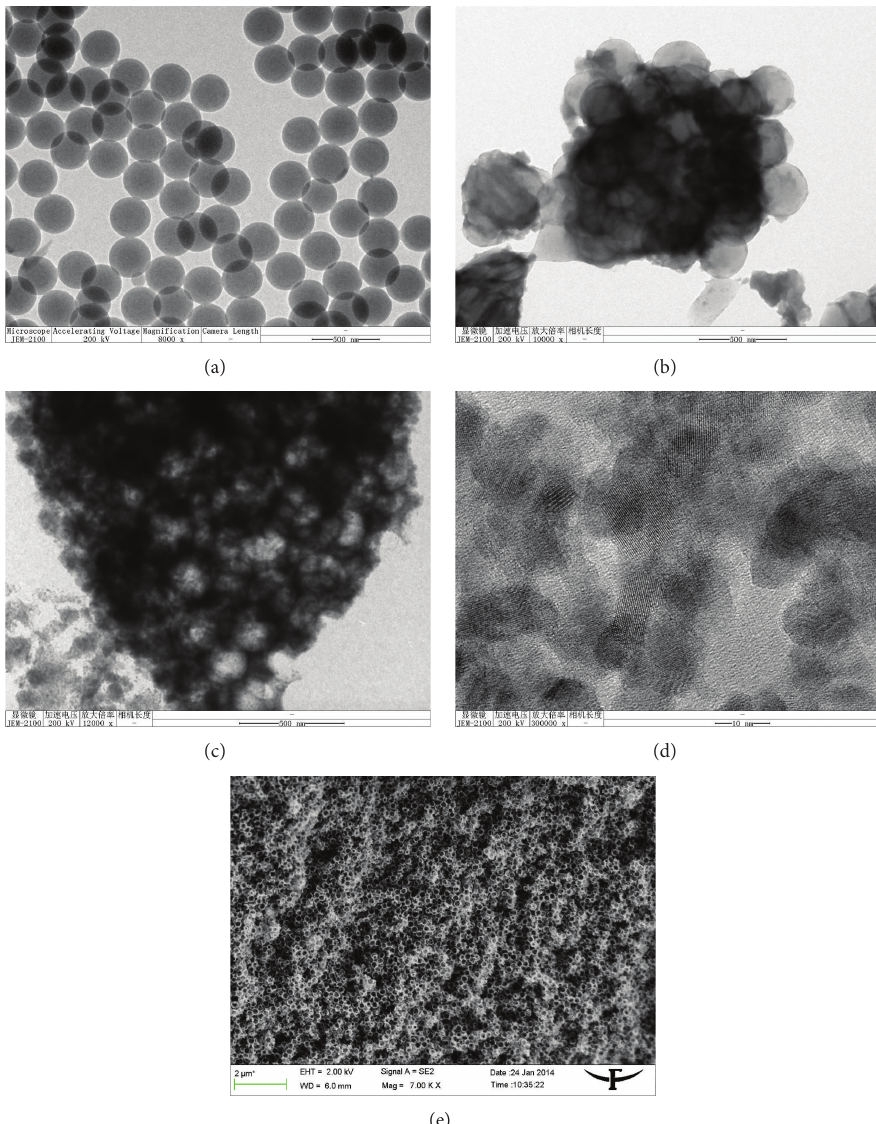
Figure 3: Low-magnification TEM images of (a) the PS spheres, (b) the TiO 2 /PS composites, (c) the m-TiO 2 catalyst after calcination at 500 ∘ C, and the high-resolution TEM image (d) and SEM image (e) of the m-TiO 2